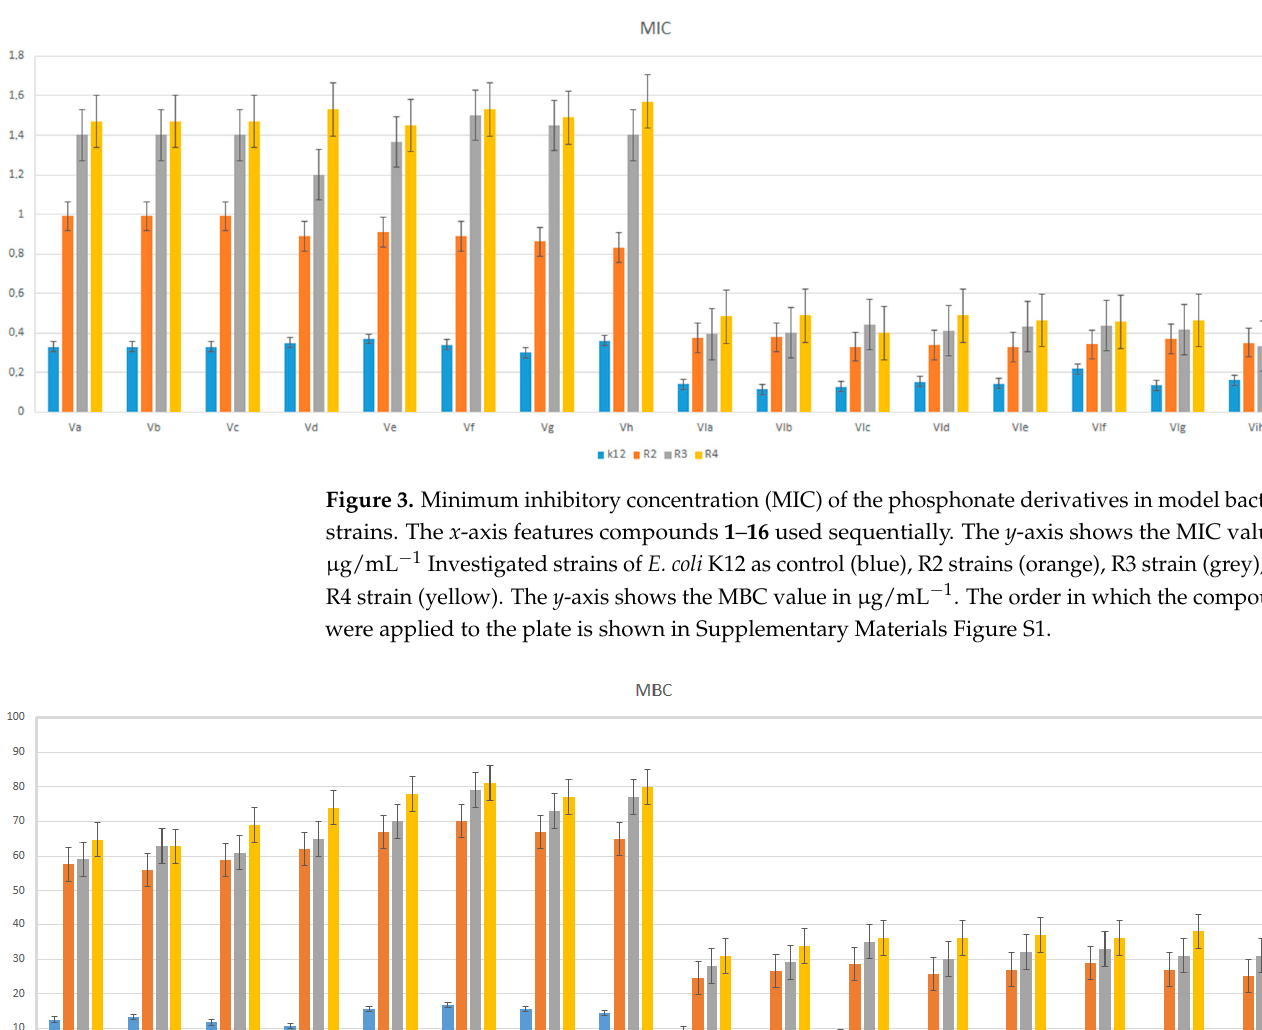
Figure 5. The ratio of MBC/MIC of the phosphonate derivatives. The x -axis features compounds Va–Vh and VIa–VIh used sequentially. The y -axis shows the MIC value. Investigated strains of E. coli K12 as control (blue), R2 strains (orange), R3 strain (grey), and R4 strain (yellow). The y -axis shows the MBC value in μ g/mL − 1 . The order in which the compounds were applied to the plate is shown in Supplementary Materials Figure S1.